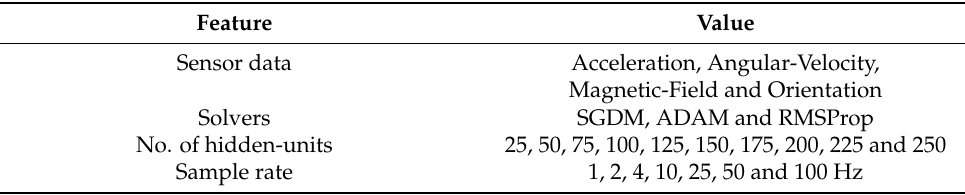
Table 2. Experimental